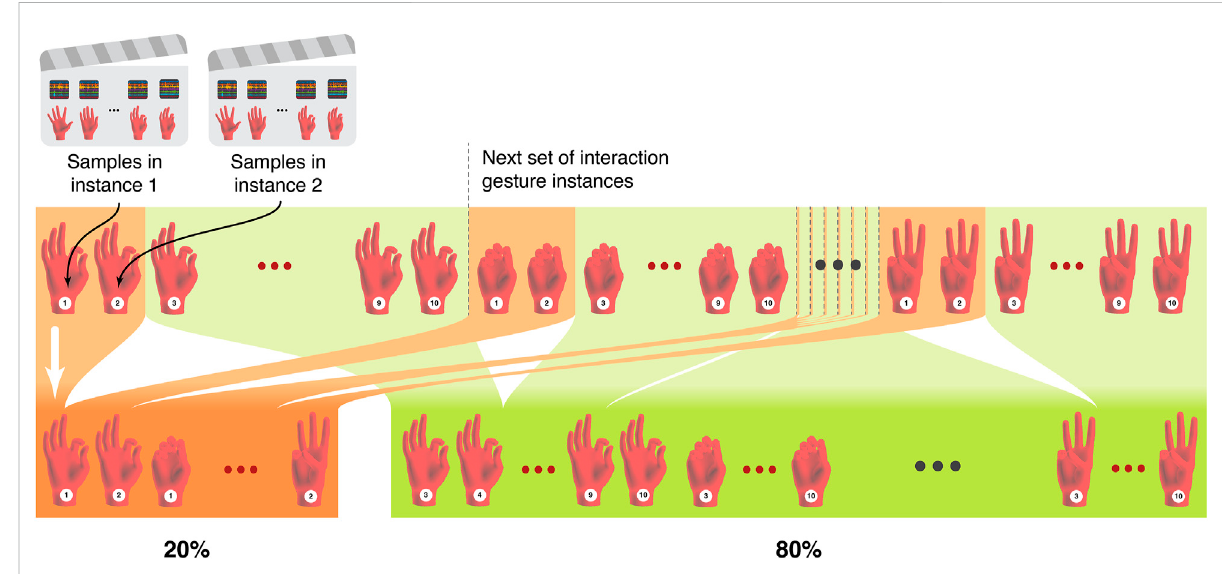
FIGURE 6 An example of the split of a speci fi c session into independent percentages by separating based on particular pose examples. This ensures that splits include equal examples of poses, and are not simply randomly